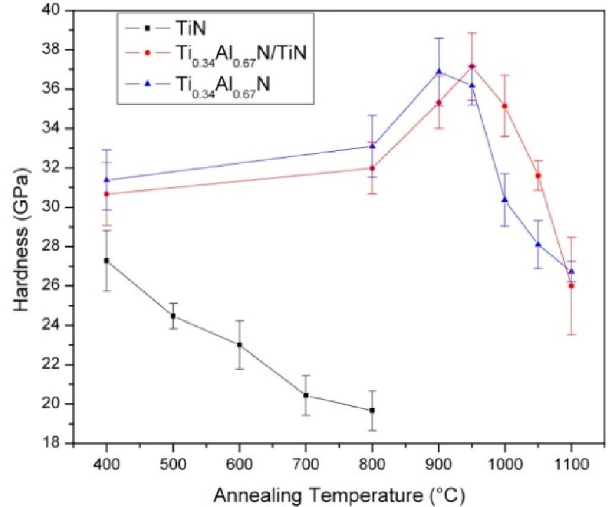
Figure 1. Hardness values obtained in [10] for the as-deposited and annealed monolithic TiN (black line with squares) and Ti Ti Al N/TiN 0.34 0.66